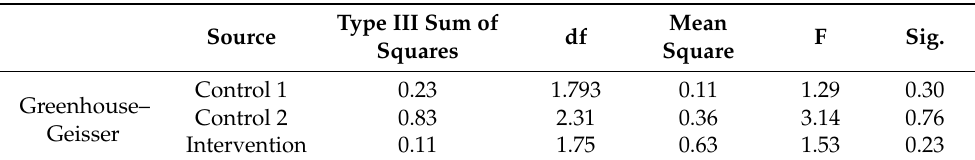
Table 4. Comparison of the mean DOPS scores for each task in three study groups using Repeated Measurement ANOVA test.